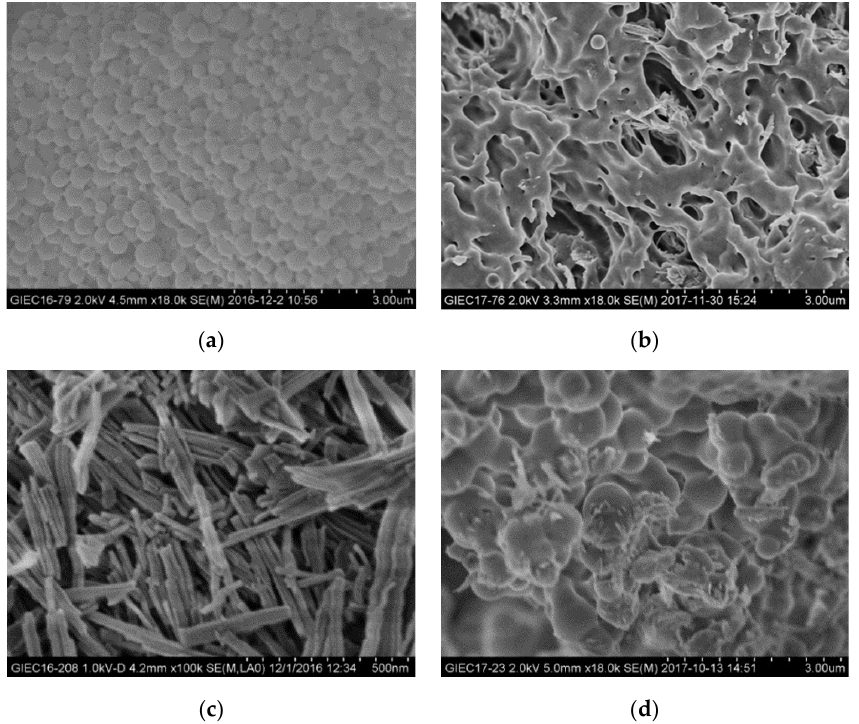
Figure 1. SEM images of poly (methyl methacrylate) (PMMA), poly(OPal-MMA), palygorskite (Pal) and the PMMA/OPal blend. ( a ) PMMA; ( b ) poly(OPal-MMA) (5 wt % OPal); ( c ) OPal; ( d ) PMMA/OPal blend (5 wt %